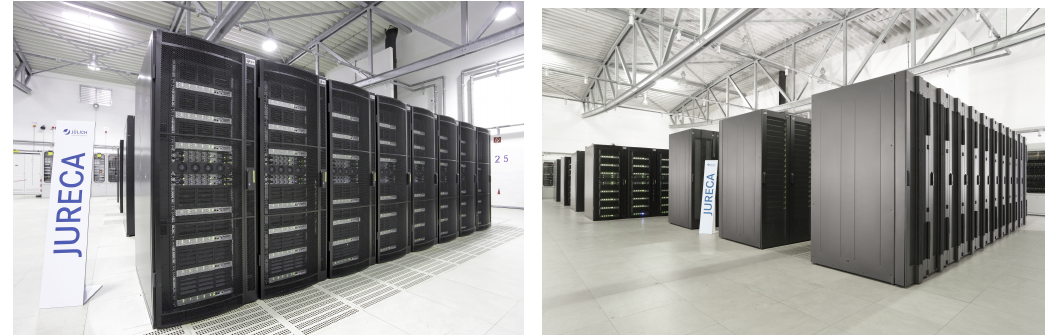
Figure 1: Jülich Research on Exascale Cluster Architectures (JURECA) at Jülich Supercomputing Centre. The left picture shows the Cluster module in 2015. The right picture shows the complete system after the Booster deployment in 2017. Copyright: Forschungszentrum